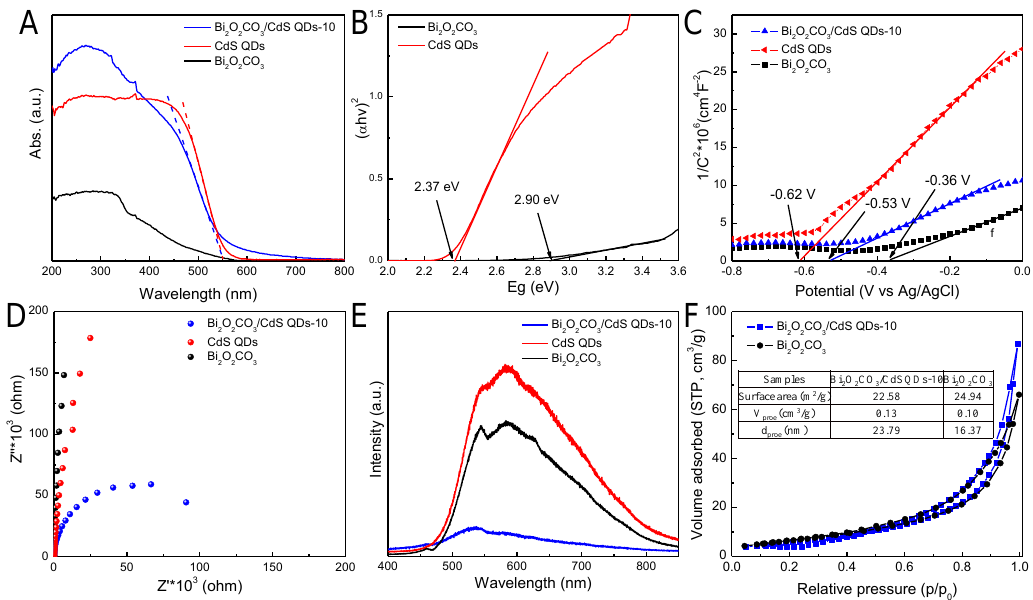
Figure 7. UV–Vis absorption spectra of Bi 2 O 2 CO 3 , CdS QDs and Bi 2 O 2 CO 3 / CdS QDs-10 ( A ); the plot of transformed Kubelka–Munk function versus the light energy of Bi 2 O 2 CO 3 and CdS QDs ( B ); Mott – Schottky plots ( C ), electrochemical impedance spectroscopy ( D ) and Photoluminescence spectra ( E ) of Bi 2 O 2 CO 3 , CdS QDs and Bi 2 O 2 CO 3 /CdS QDs-10; Nitrogen adsorption-desorption isotherms (The inset is the inserted table of the calculated BET surface areas, V pore and d pore ) of Bi 2 O 2 CO 3 and Bi 2 O 2 CO 3 /CdS QDs-10 ( F ).